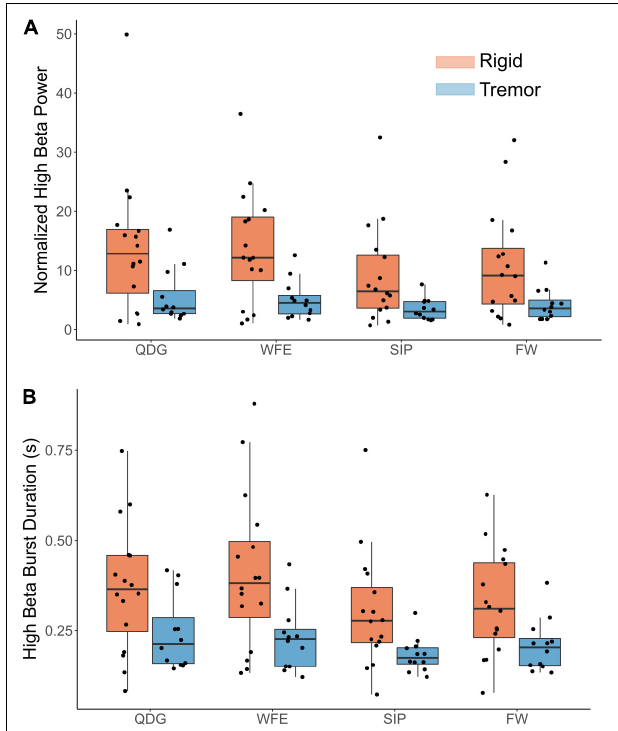
FIGURE 5 | (A) Normalized high beta peak power and (B) high beta burst durations by task and phenotype. Note, a significant main effect was observed between groups ( p < 0.05) but not task, and there was no significant interaction effect.